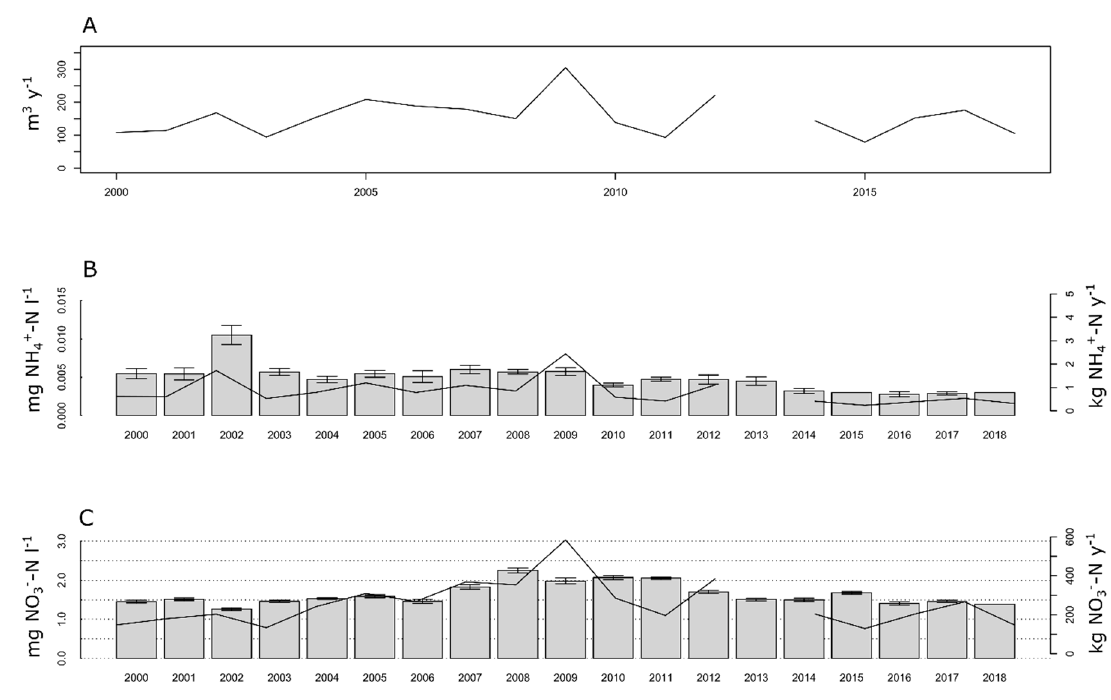
Figure 5. ( A ) Annual discharge, ( B ) NH 4+ -N and ( C ) NO 3 − -N concentrations, and runoff at the gauging station 551 (bars: concentrations in mean ± SE, lines: fluxes).